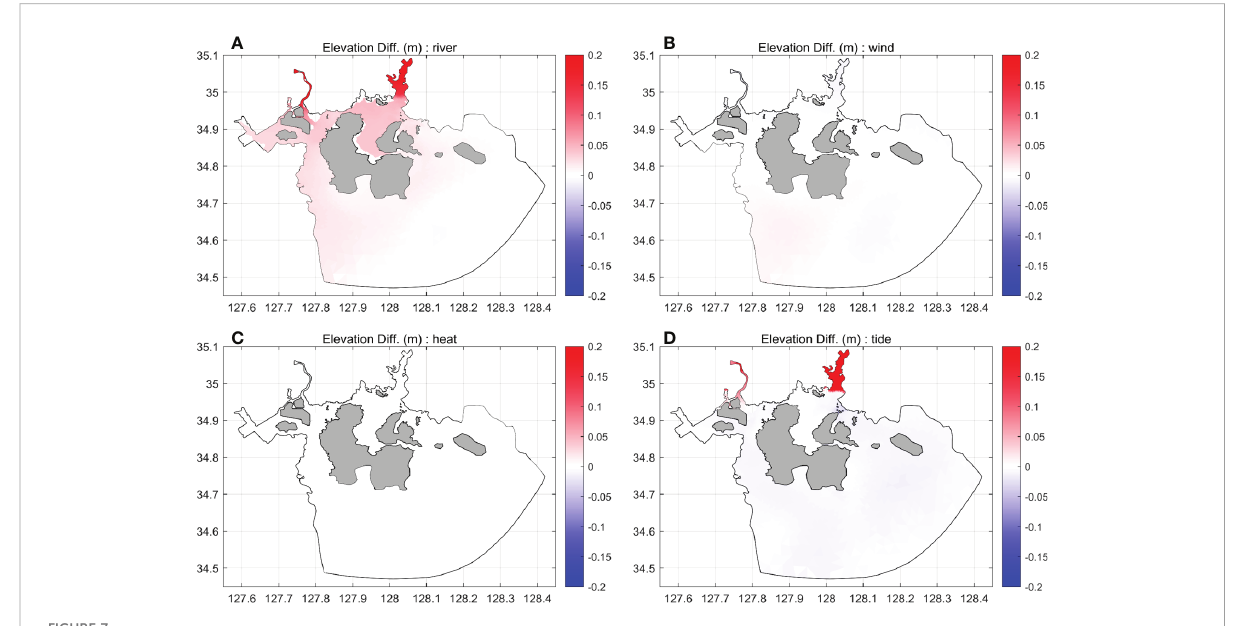
FIGURE 7 Same as Figure 5, but with surface